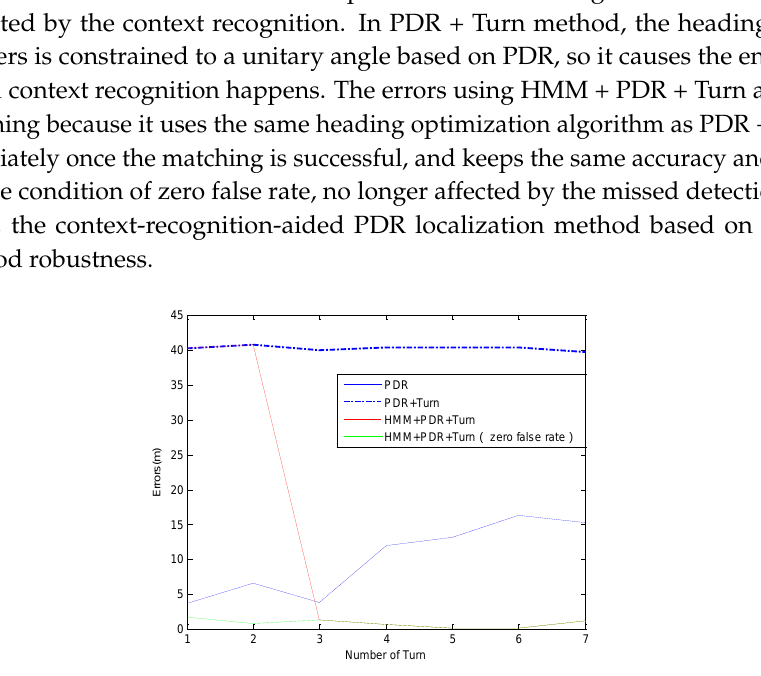
Figure 15. The comparison of positioning errors with different false rate.